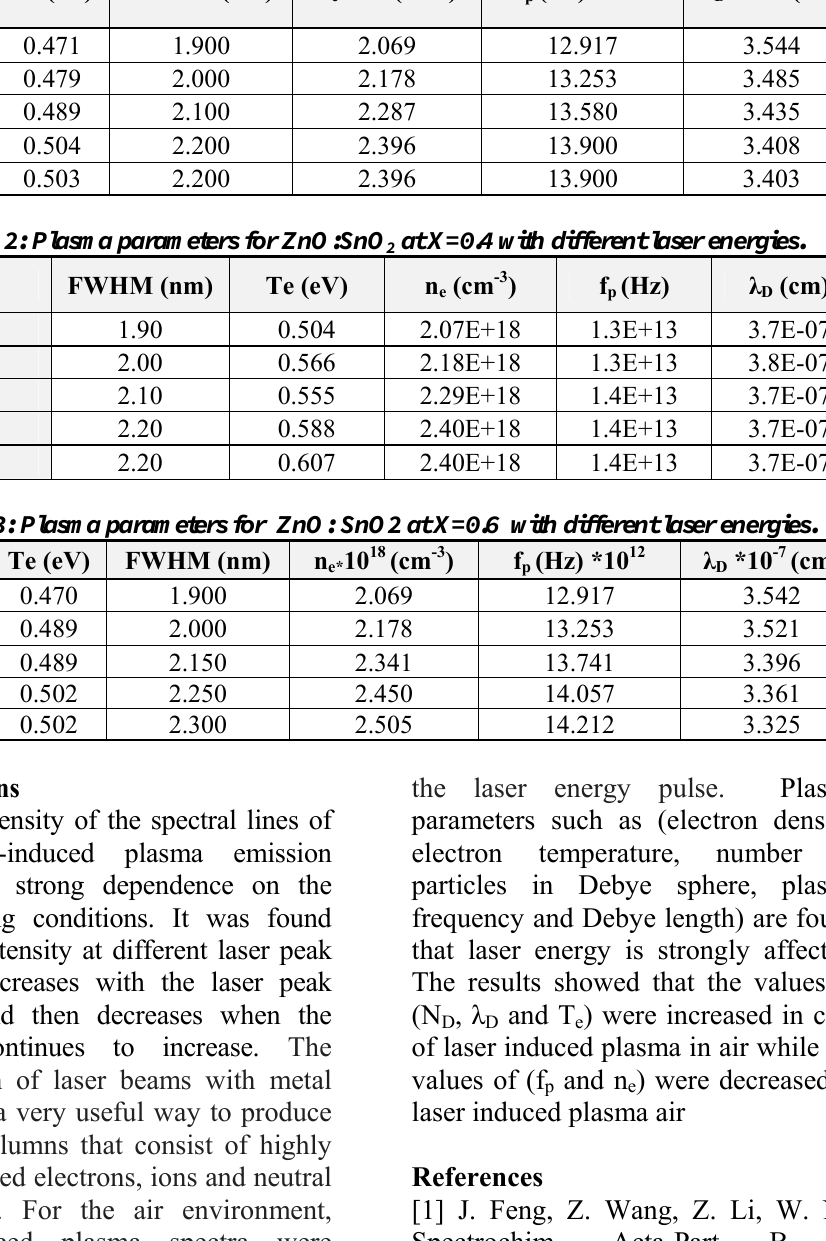
Table 1: Plasma parameters for ZnO: SnO E(mJ)